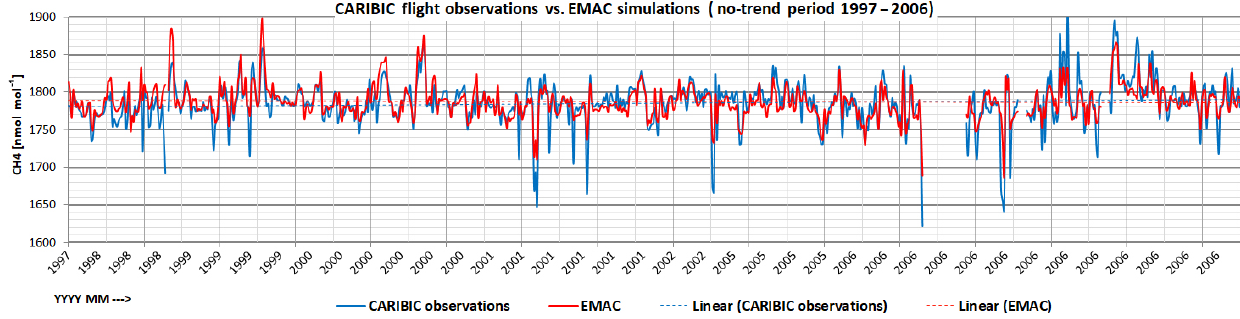
Figure 7. EMAC CH 4 calculations (red) and CARIBIC-1/2 observations (blue) from 1997 to 2006 – all flight samples.